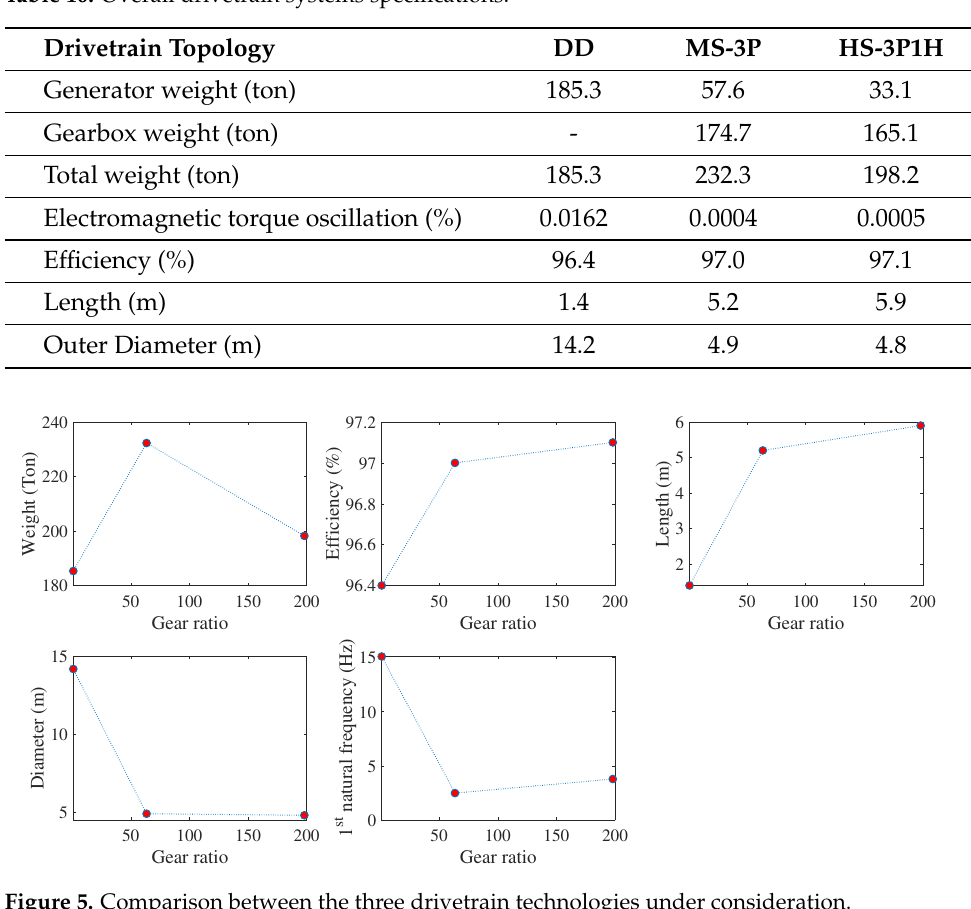
Figure 5. Comparison between the three drivetrain technologies under